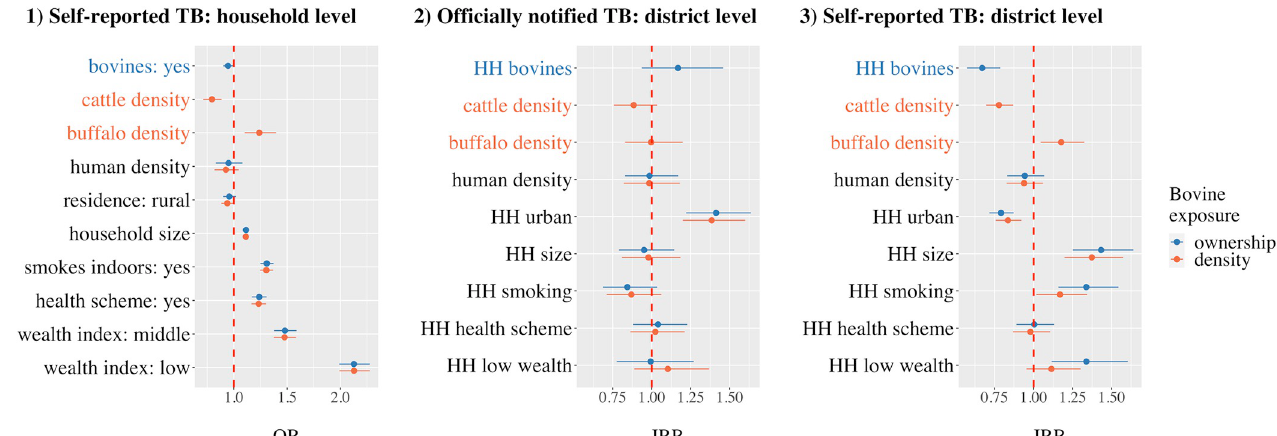
Fig 3. Mean fixed effects and 95% credible interval of potential risk factors for model 1) self-reported tuberculosis in households, model 2) officially notified tuberculosis at district level, and model 3) households with self-reported tuberculosis at district level in India. For each model, one out of two bovine exposure measures were assessed: bovine ownership in households (in blue) or cattle and buffalo density (in orange). Please note different axes for 1) and 2–3). OR = odds ratio, IRR = incidence rate ratio.